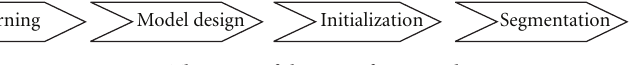
Figure 1: The steps of the ASM framework.